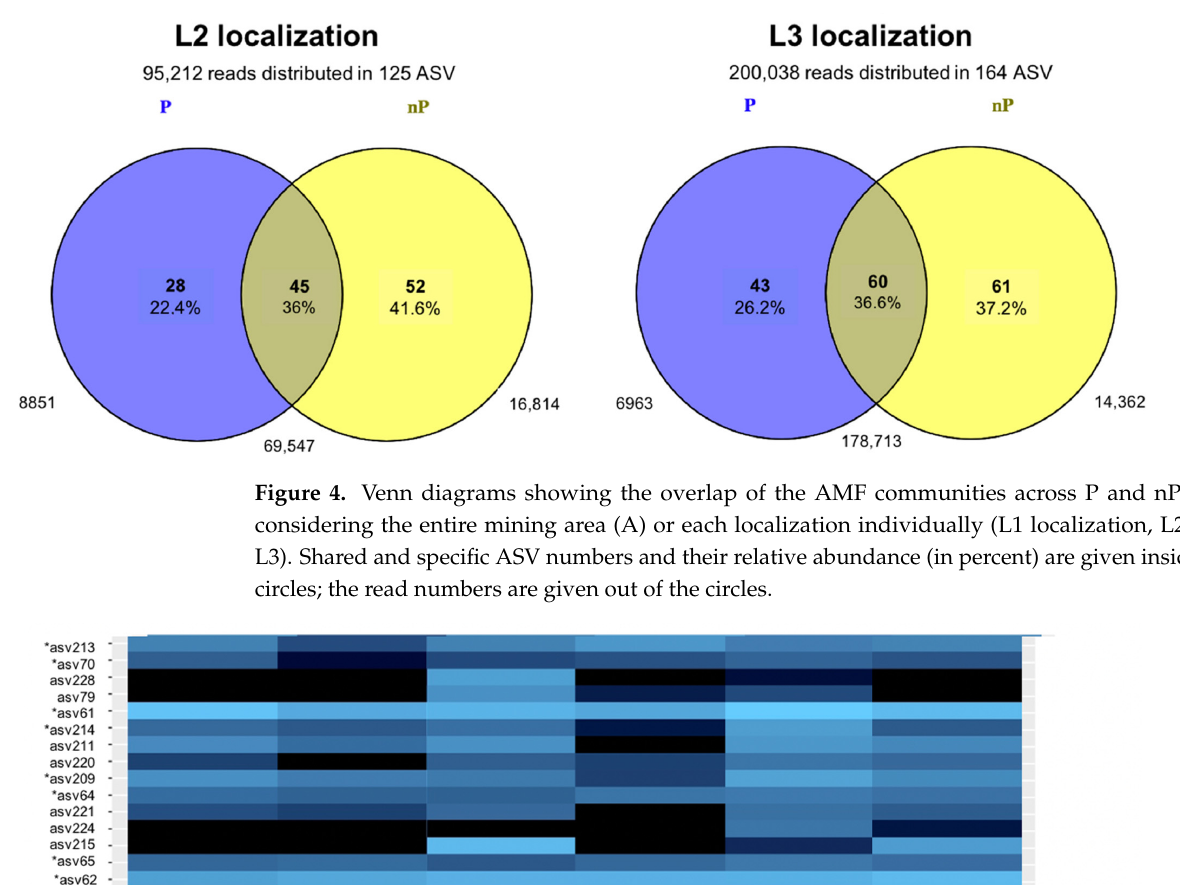
ual group, or in combination (Table S7). Thus, in particular, seven nP-indicator ASVs and one P-indicator ASV were identified. All of them were assigned to Glomeraceae. Regarding the taxonomic classification, no Archaeosporaceae member was observed in P soils. Paraglomeraceae and Glomeraceae tend to be reduced in P soils in terms of ASV percentages (Figure 6). In contrast, Diversisporaceae and Claroideoglomeraceae families tended to have increased with the P content. Lower percentages of assigned ASV were recorded at genus and species levels in P soils (Figure 6). In addition, comparisons between the three P sites were made. Different ASVs be- tween the three P sites were identified with a higher number of site-specific ASVs and few shared ASVs, as shown in the Venn diagrams (Figure S4A). The same trend occurred com- paring the nP sites (Figure S4B).